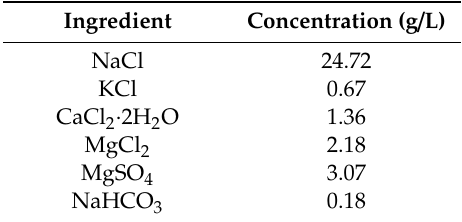
Table 1. The chemical compositions of artificial seawater (30% (cid:24)